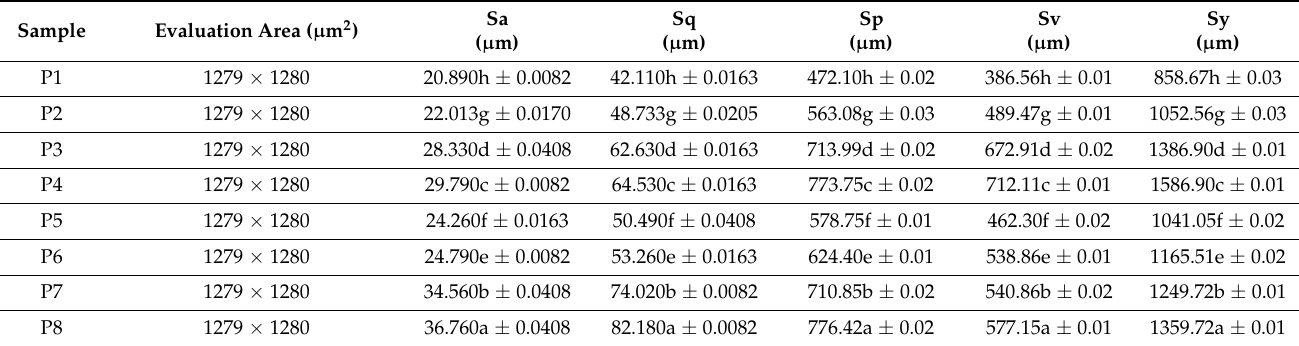
Table 5. Calculated roughness of